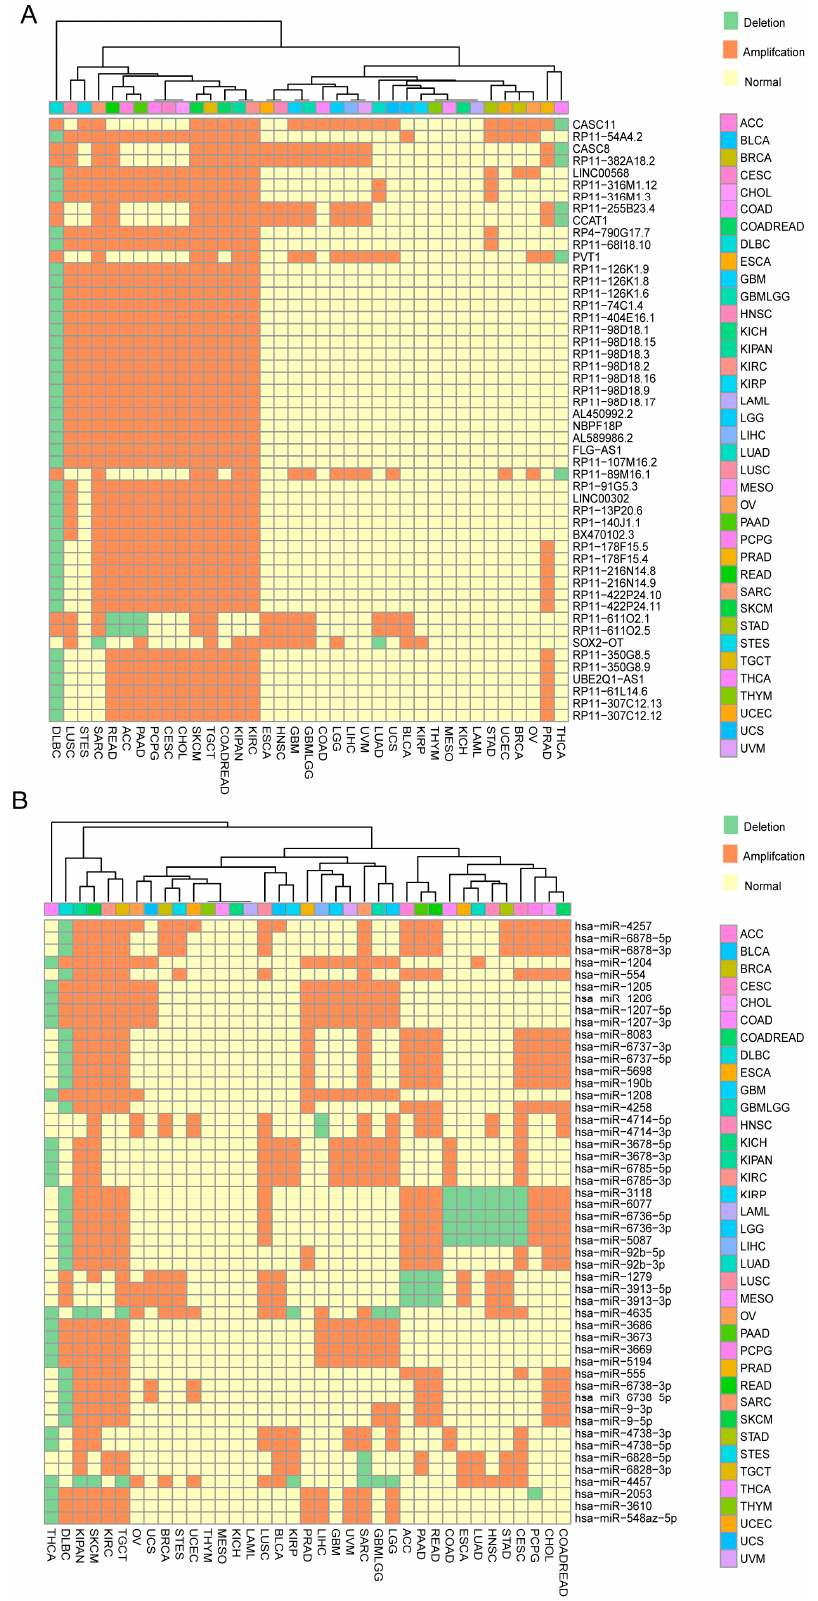
Figure 2. The amplification signatures for the top long non-coding RNAs (lncRNAs) and microRNAs (miRNAs) in the most cancer types. ( A ) The top 50 lncRNAs annotated by GENCODE V19 with the most cancer types for amplification; ( B ) The top 50 miRNAs with the most cancer types for amplification in 37 TCGA tumors.